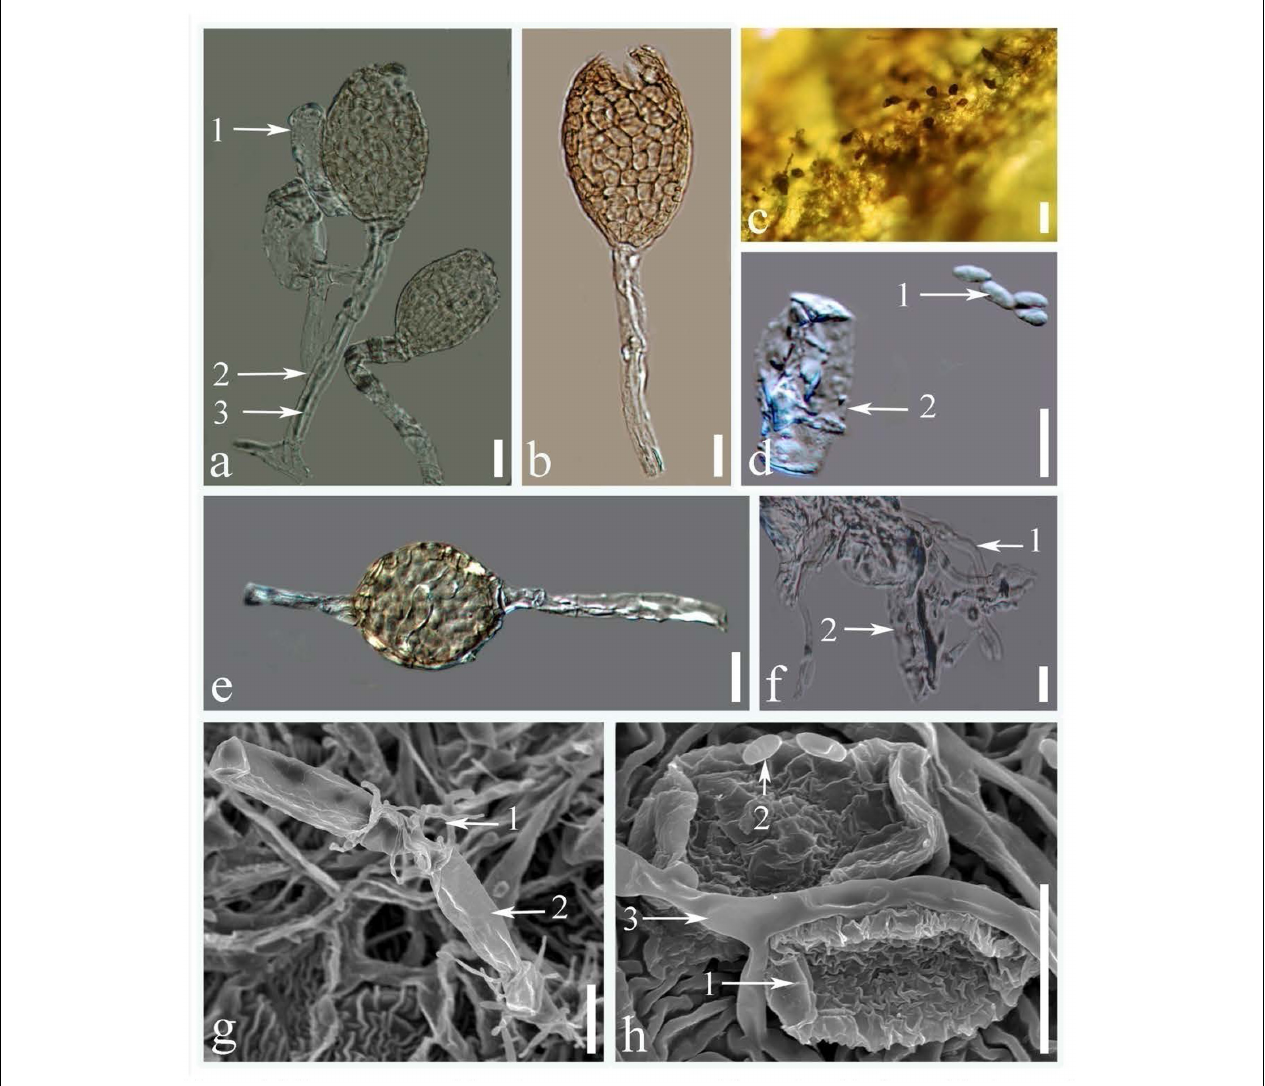
FIGURE 2 | Microstructures of Ampelomyces spp.: (a) pycnidia produced in the conidiophores of rubber powdery mildews (1. conidia of rubber powdery mildew; 2. conidiophores of rubber powdery mildew; 3. intracellular hyphae of Ampelomyces spp.); (b) dehisced pycnidium by apical rupture; (c) pycnidium on the surface of a rubber leaf; (d) conidia (1. conidia of Ampelomyces spp.; 2. conidia of rubber powdery mildew); (e) pycnidia produced inside the hyphae of rubber powdery mildews; (f) superficial mycelium mat (1. mycelium of Ampelomyces spp.; 2. mycelium of rubber powdery mildew); (g) superficial growth of Ampelomyces mycelium on catanate type of conidia in rubber powdery mildew (1. mycelium of Ampelomyces spp.; 2. catanated conidiospore of rubber powdery mildew); (h) mycelium and spores of Ampelomyces spp. (1. non-catenate conidia ( Erysiphe quercicola ); 2. conidia of Ampelomyces spp., 3. mycelium of Ampelomyces spp.) (Scale bars: figures a,b,d–h = 10 µ m, figure c = 20 µ